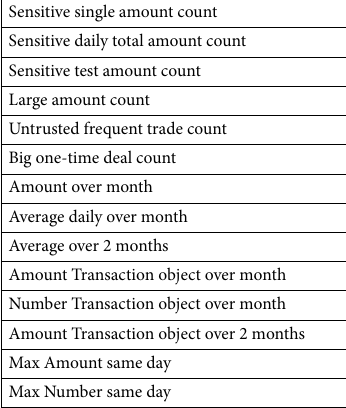
Table 6. Features proposed by Xie et al.